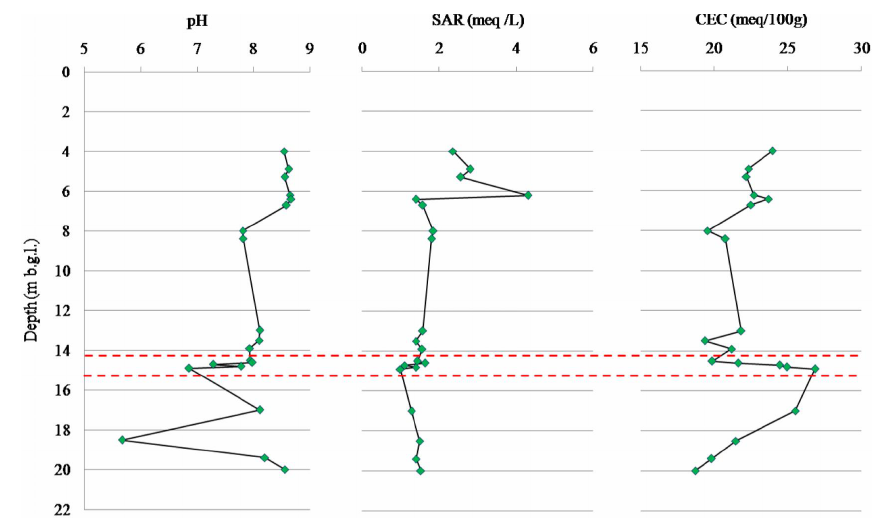
Figure 10. Trends of pH, sodium absorption ratio (SAR) and cation exchange capacity (CEC) variations with